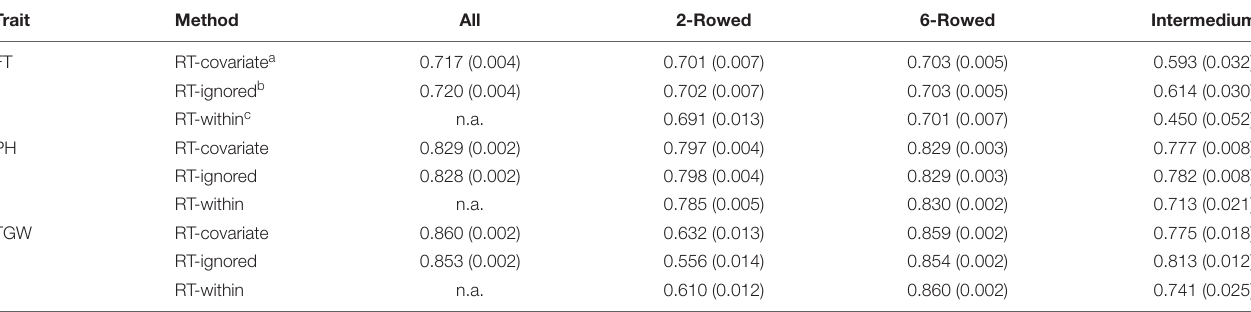
TABLE 2 | Genome-wide prediction abilities of flowering time (FT), plant height (PH), and thousand grain weight (TGW) obtained by applying five-fold cross validation to the entire set of phenotyped winter barley accessions modeling the row type as covariate